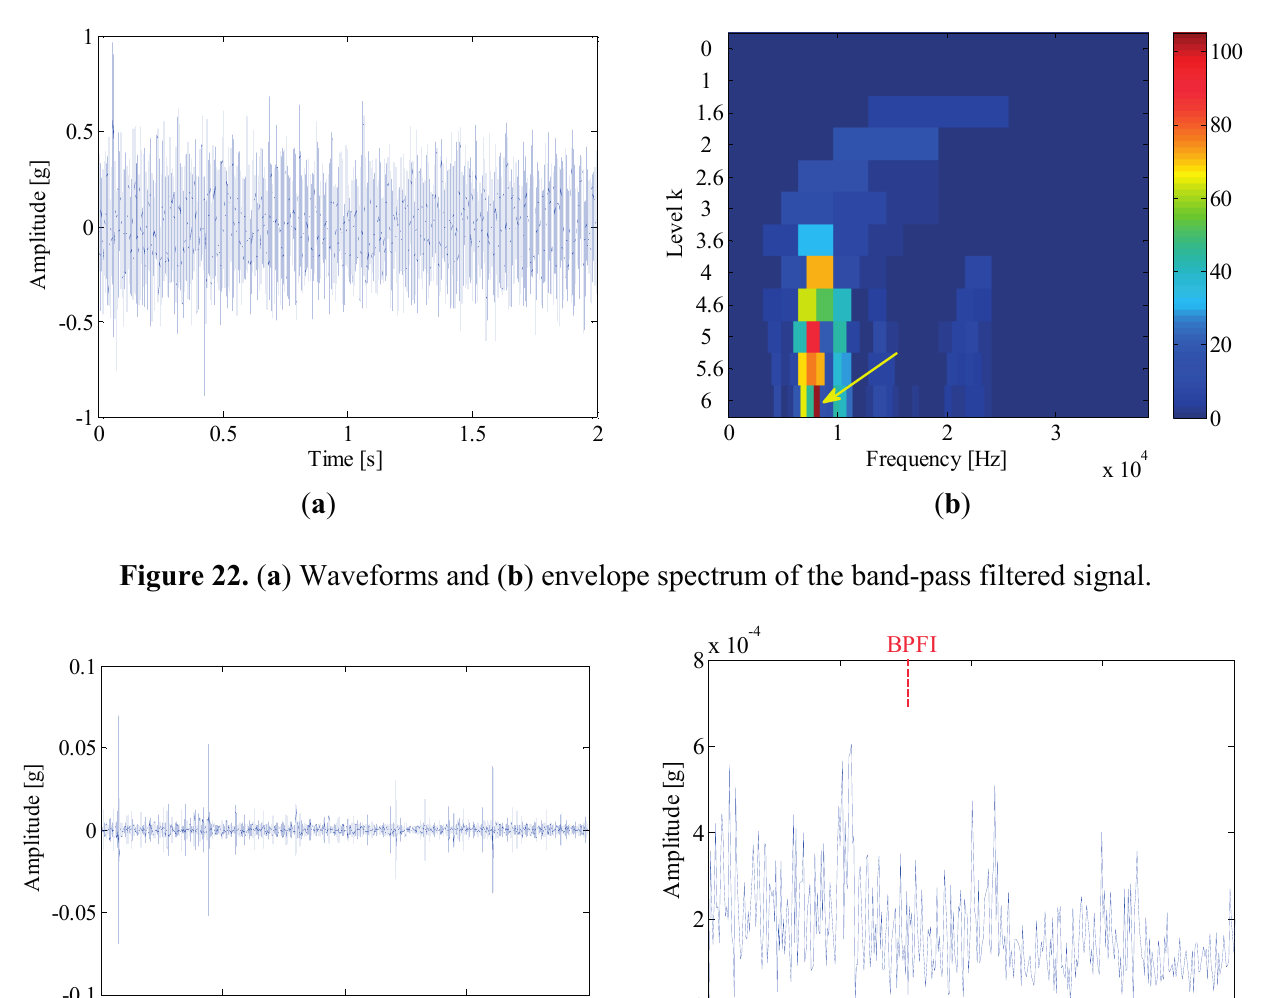
Figure 21. ( a ) Waveform and ( b ) kurtogram of the bearing signal.